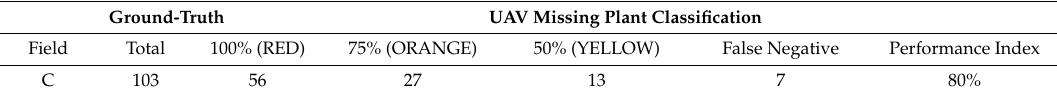
Table 5. Missing plants observation (Ground vs.